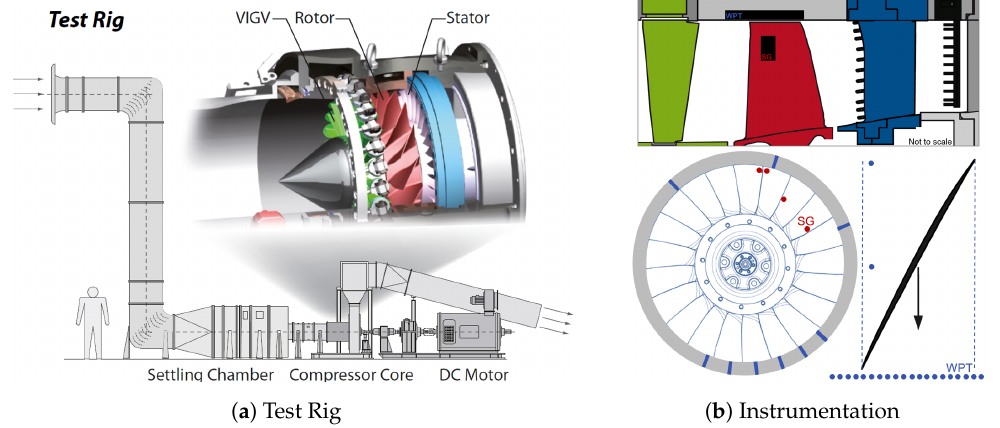
Figure 1. Transonic Compressor Darmstadt and